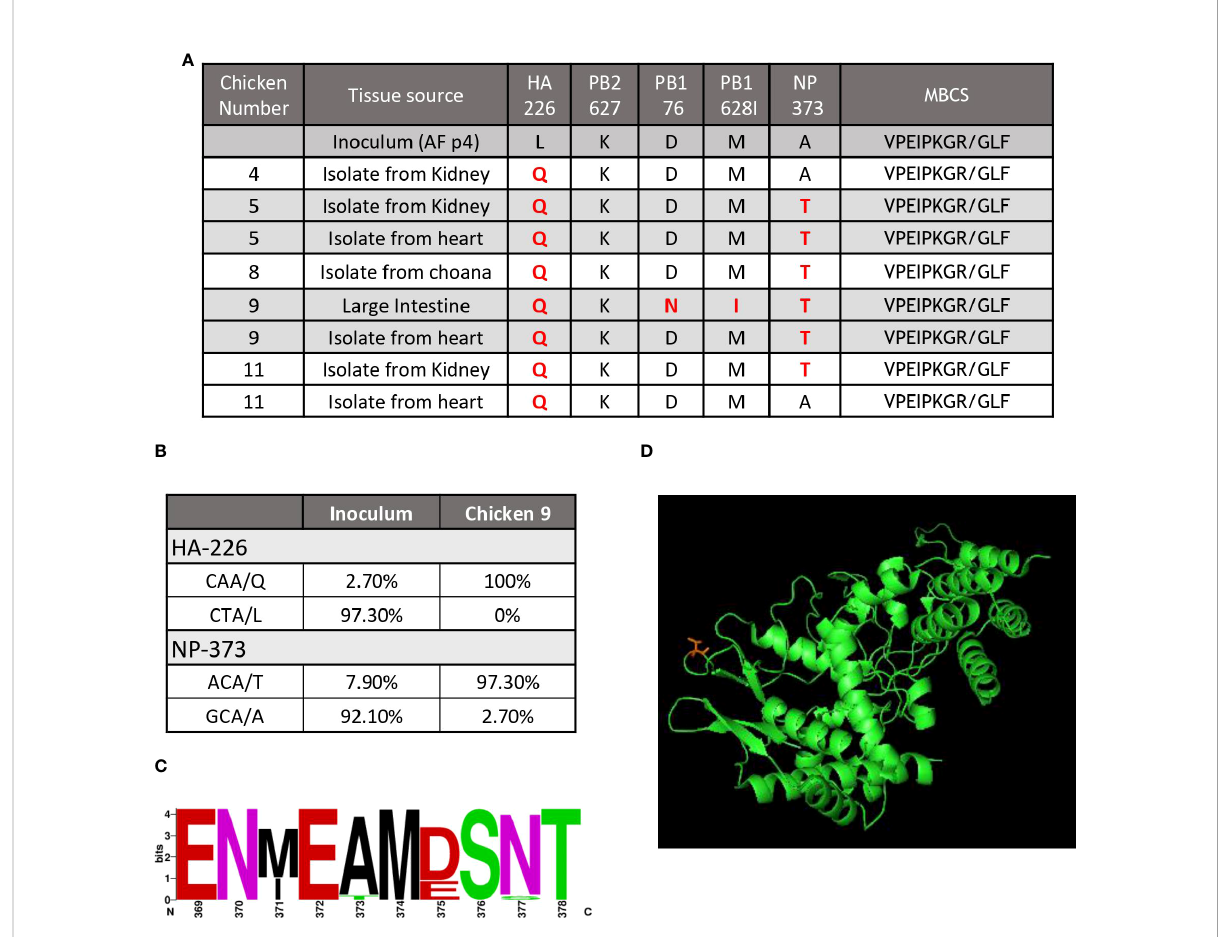
FIGURE 3 A mutation in the NP correlated with disease outcome. (A) The table shows a summary of the results of genome sequencing of virus isolated from H7N9 infected chickens. Key, known mutations, including presence absence of the MBCS associated with pathogenesis are shown. Changes are highlighted in red. (B) NGS quanti fi cation of two key mutations demonstrates the abundance (shown as percentage) of each mutation from the inoculum and a heart isolate from an infected chicken (chicken #9). (C) The sequence logo shows the abundance of different amino acids from available Genbank sequences for aa369-378 of the in fl uenza NP protein (D) and predicted protein folding of the in fl uenza NP protein showing amino acid 373 (T) (in red) on a solvent exposed side